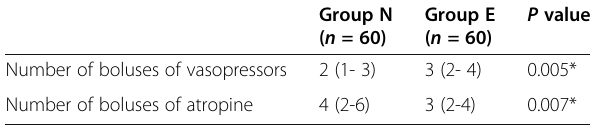
Table 2 Number of boluses of vasopressor and atropine used